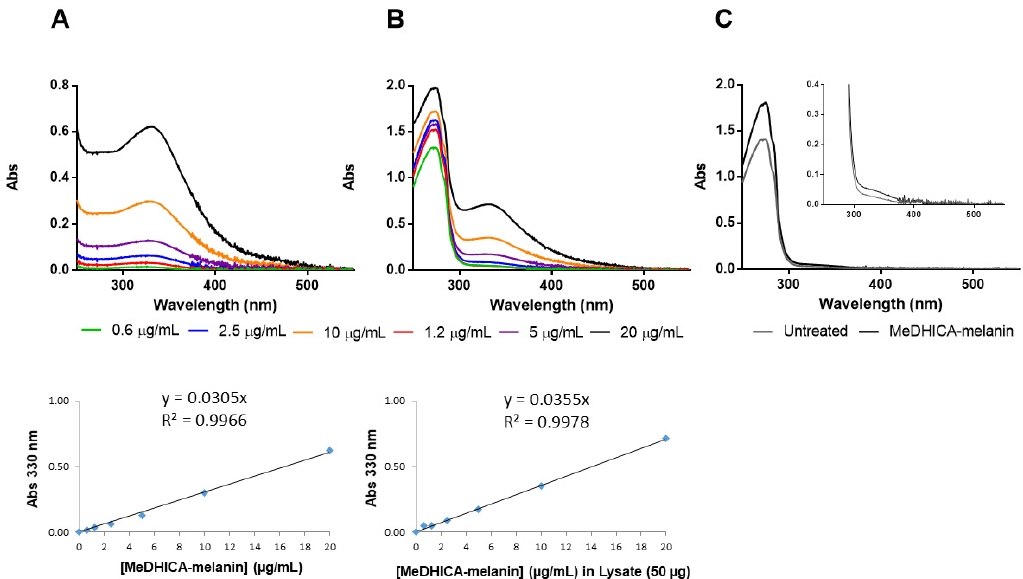
Figure 6. Quantification of internalized MeDHICA-melanin. Increasing concentrations (0.6–20 µ g / mL) of MeDHICA-melanin, ( A ) alone, or ( B ) in the presence of 50 µ g of cell lysate, were used to record the UV–vis spectra. Calibration curves built by plotting values of absorbance at 330 nm against MeDHICA-melanin concentration are also shown. ( C ) UV–vis spectra of untreated cells (grey line) and MeDHICA-melanin treated (black line) HaCaT cells.